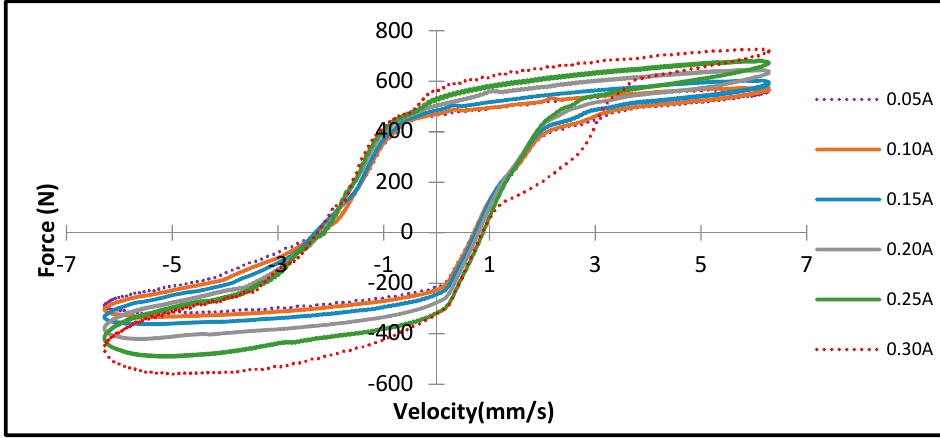
Figure 16. Damping force versus piston velocity (measured).